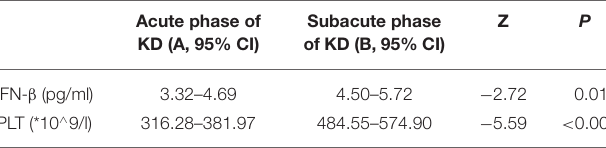
TABLE 3 | Comparison of IFN- β and PLT between acute phase of KD and subacute phase of KD.